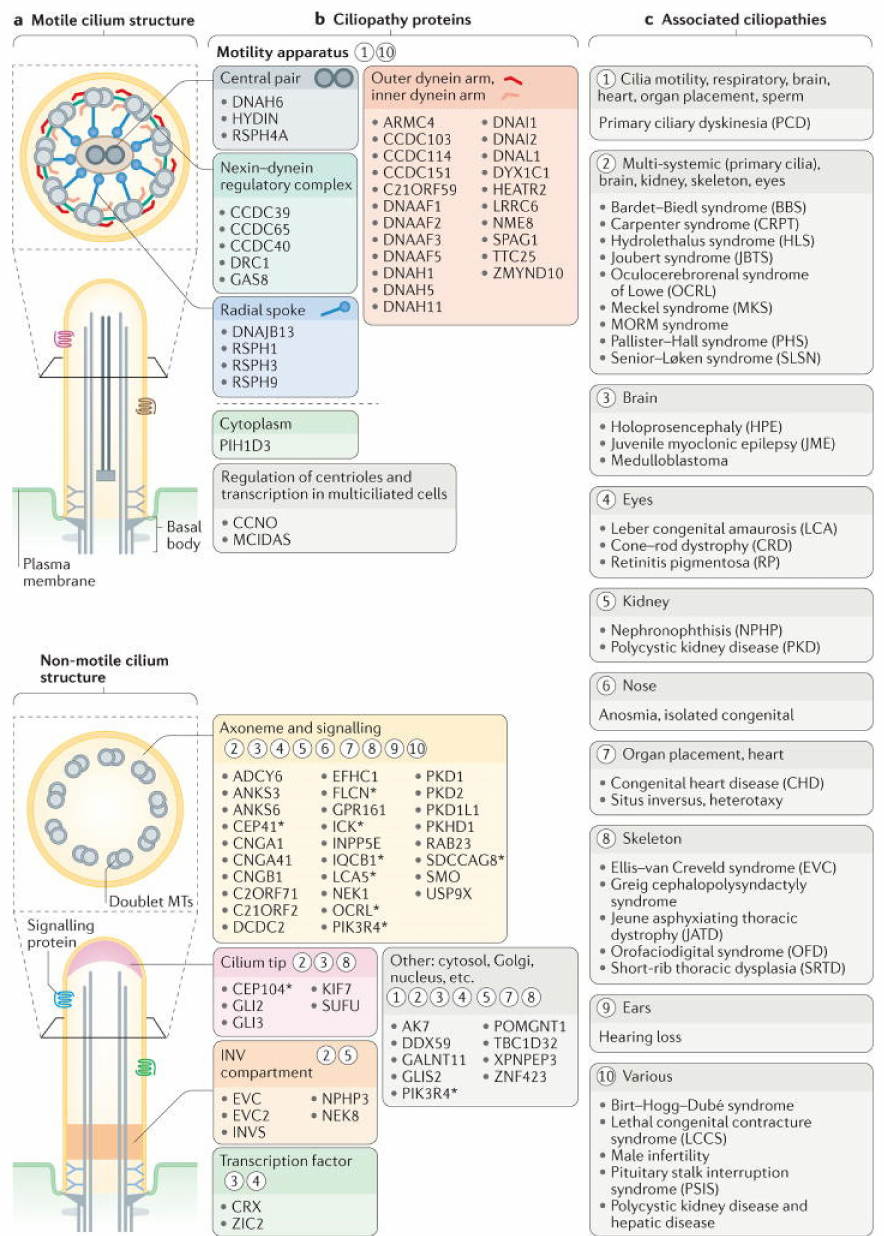
Figure 4. Structural and functional features of motile and sensory cilia are associated with ciliopathies. ( a ) the major structures of motile and non-motile cilia. ( b ) Major sites of action for ciliopathy- associated proteins that are components of motile cilia (motility apparatus or transcription factors required for the generation of motile cilia) and sensory cilia (axonemal and signaling proteins, ciliary tip proteins or inversin (INV) compartment proteins). The asterisks indicate proteins that are also localized to other ciliary regions during ciliogenesis or ciliary trafficking. Circled numbers indicate one or more ciliopathies that result from defects in the different ciliary compartments and proteins. ( c ) Ciliopathies grouped into major categories that are associated with proteins and ciliary regions in part B. Reproduced from [7], with